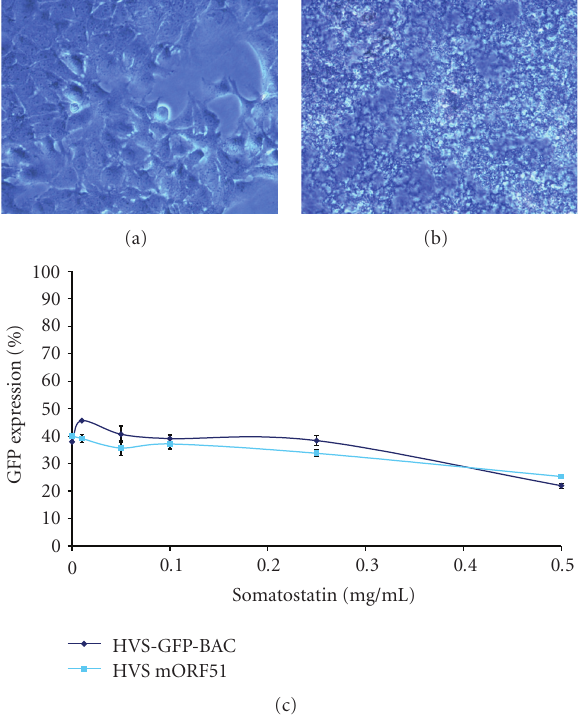
Figure 11: Somatostatin fails to neutralise HVS infection. The 14- amino acid peptide somatostatin was incubated with Huh7.5 cells at a range of concentrations for 1h prior to infection with either HVS-GFP-BAC or HVS mORF51. After 48 h, GFP fluorescence was measured by flow cytometry ( n = 2). Although cells incubated with up to 0.5mg/ml somatostatin appeared healthy under the microscope (a), a concentration of 1mg/ml was lethal (b). The graph (c) shows that both viruses exhibited negligible change in cell entry with increasing somatostatin concentration until the 0.5mg/ml samples, where there is a reduced infection for both viruses. This may be due to the toxicity of the peptide rather than a true neutralisation e ff ect.